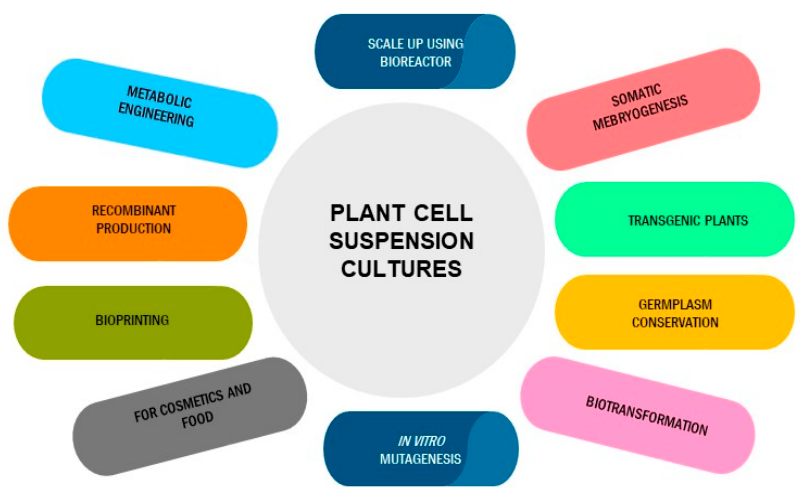
Figure 1. Potential applications of plant cell cultures. Rare and endangered plants can be conserved in vitro in the form of cell suspensions (in vitro germplasm preservation), and also the cells can be treated with physical and chemical mutagens for generating variations in the secondary metabolite content. The rest of the applications are explained in the text.